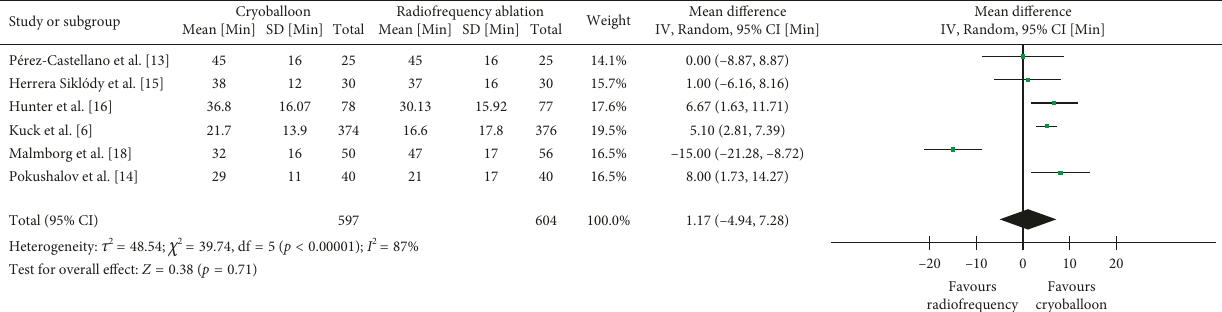
Figure 7: Mean fluoroscopy time in minutes with 95% CI in patients receiving cryoballoon versus radiofrequency ablation.